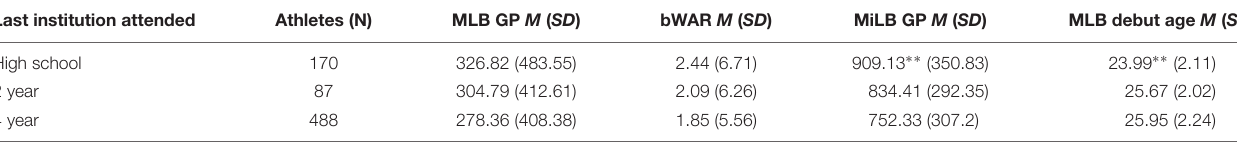
TABLE 2 | MLB and MiLB descriptive statistics – position players.